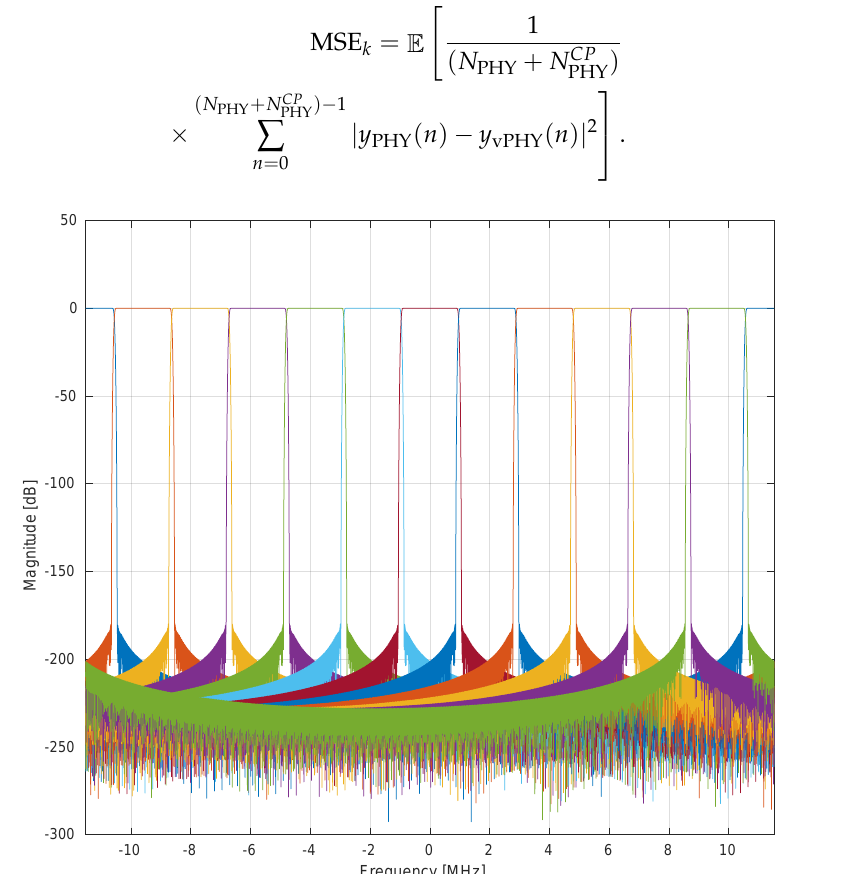
Figure 10. Frequency response of a polyphase filter-bank with stop-band attenuation of 180 [dB] and 512 filter coefficients per